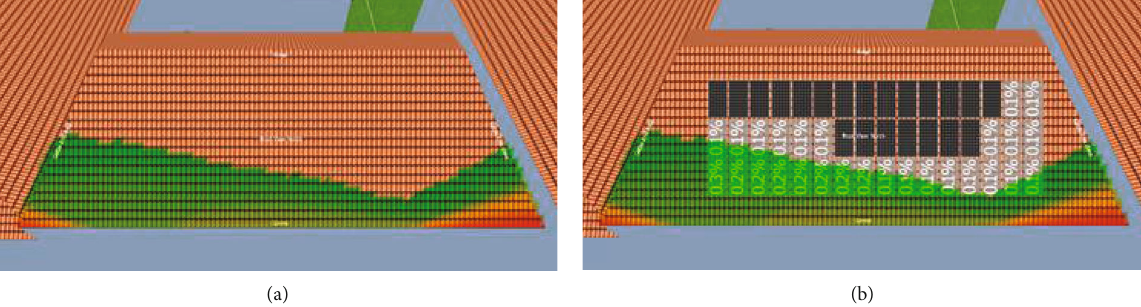
Figure 8: Examples of the shading analyses with PhotoPlan 3D in PV ∗ Sol Premium: (a) without PV and (b) with PV.